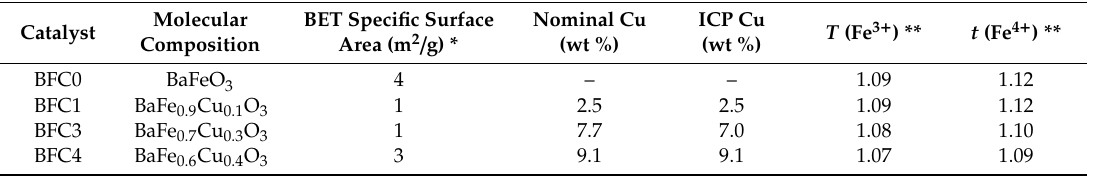
Table 1. Molecular composition, specific surface area, copper content, and Goldschmidt tolerance factor ( t) * values for BaFe 1 − x Cu x O 3